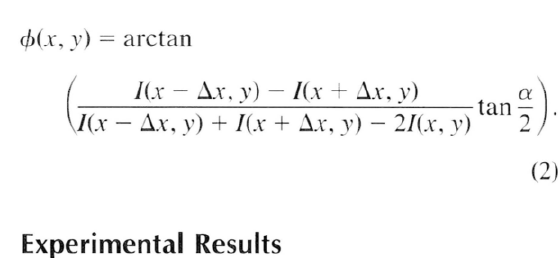
FIGURE 5 Speckle interferogram of a vibrating plate.